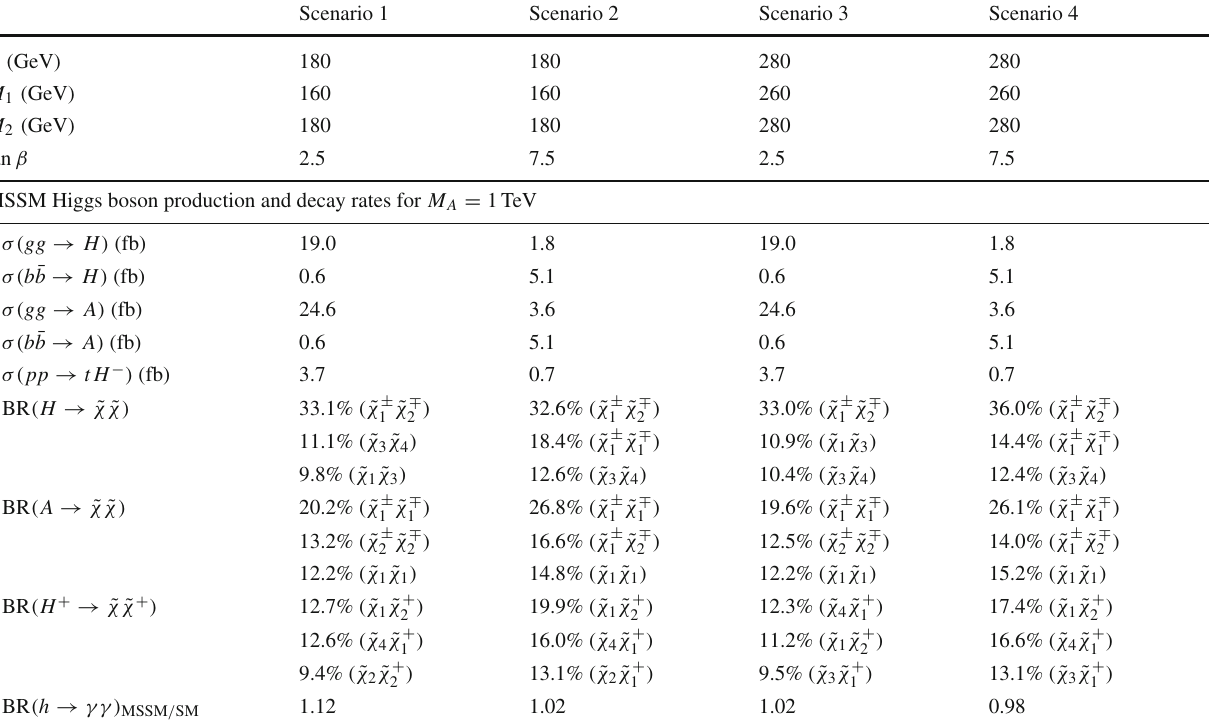
Table 2 A detailed view on two parameter points from the M 125 scenario (scenario 1 and 2), as well as two variations (scenario 3 and 4): relevant parameters for the electroweak sector (top); rates of the